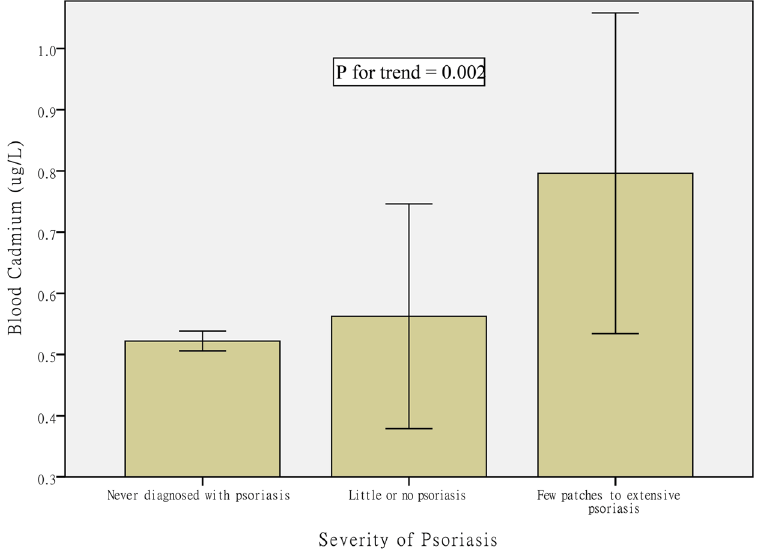
Figure 1. Psoriasis and Cadmium. Mean values of blood cadmium across severity of